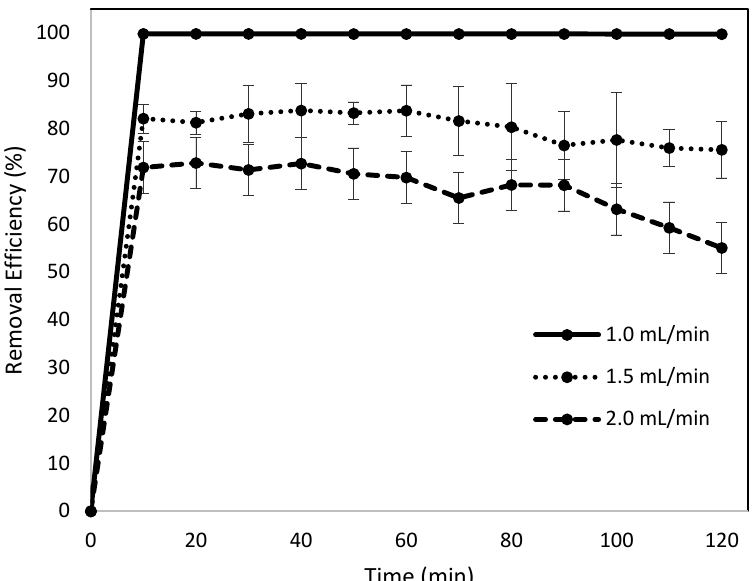
Figure 8. The effects of three different flow rates on removal efficiency over a 120 min period (bead size = 200 µm, voltage = 60 V).